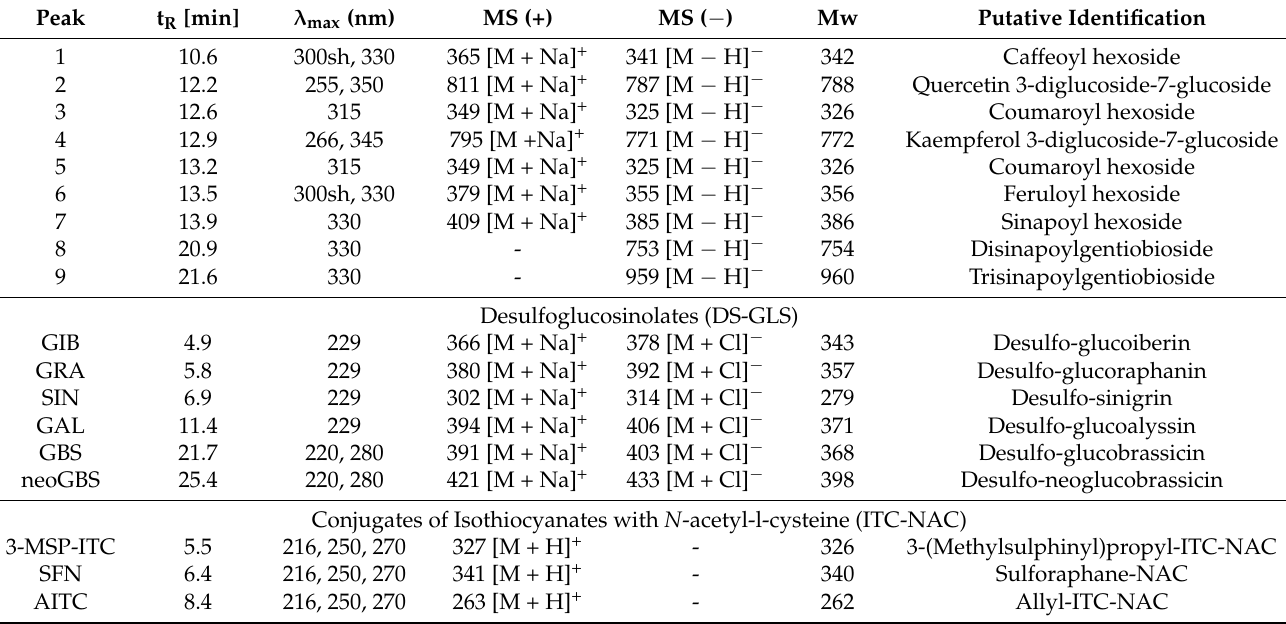
Table 2. Chromatographic and spectrometric data obtained during HPLC-DAD-MS analyses of cabbage leave extracts used for putative identification of major secondary metabolites. Putative identification is given for all peaks numbered from 1–9 for phenolics and coded by letters for the desulfo-glucosinolates (DS-GLS) and their degradation products